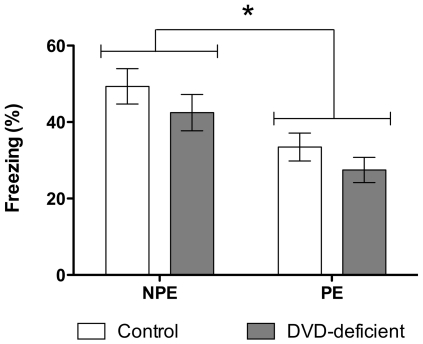
LI in the retention test session (Day 4).Data show the freezing scores (%) for control and DVD-deficient mice in the NPE (n = 31) and PE (n = 30) groups. Mice in the PE groups exhibit less conditioned freezing than NPE mice (Main effect of Pre-exposure F
1,114 = 13.03, P<0.001), indicating LI (the inhibition of learning caused by pre-exposure to the CS). Data are expressed as mean ± SEM. * P<0.05 between NPE and PE mice.